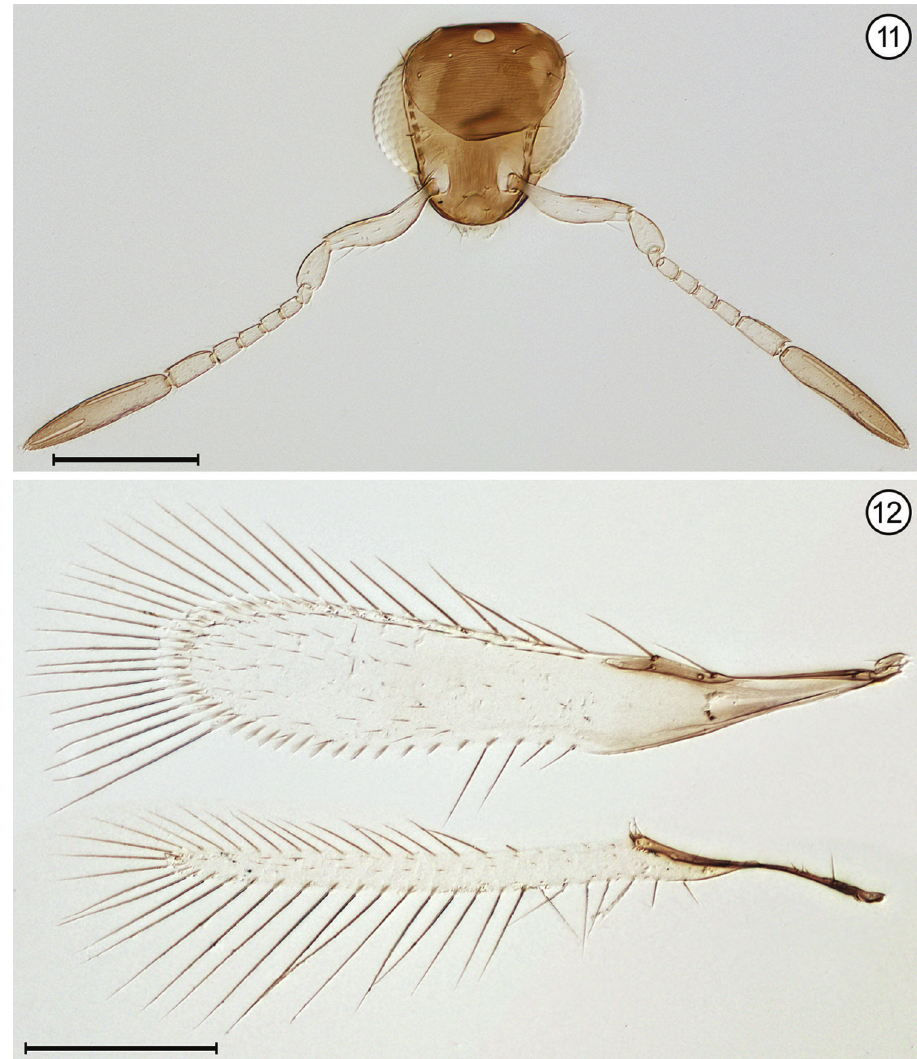
Figures 11, 12. Erythmelus sp., female 11 head, anterior + antennae 12 wings. Scale bars = 100